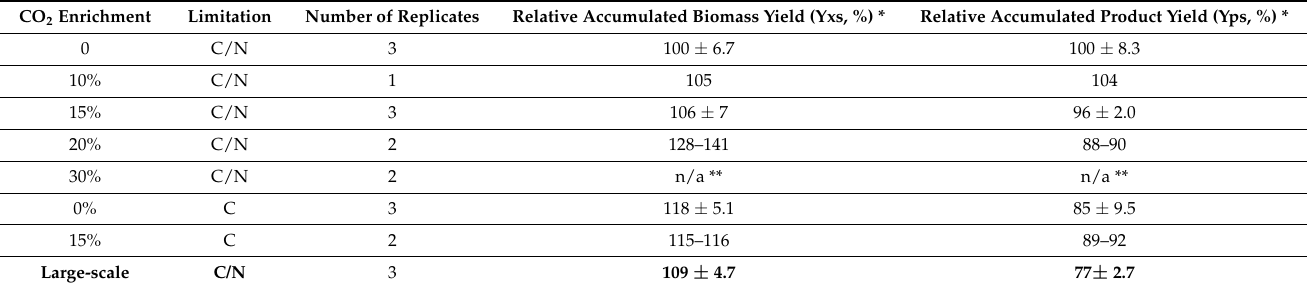
Table 1. Relative accumulated biomass and product yield on